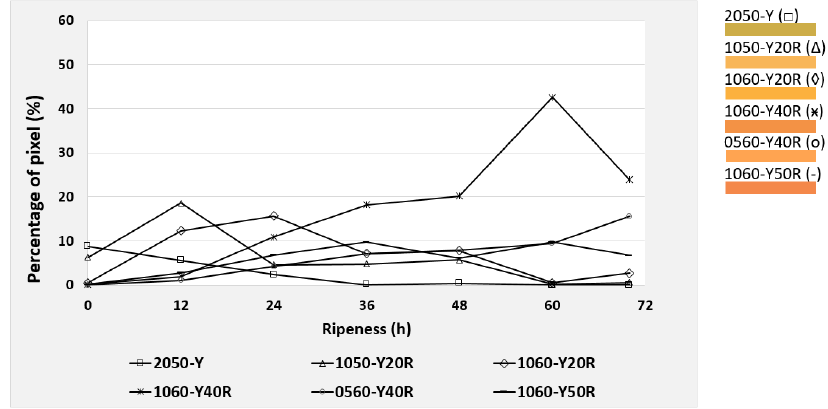
Figure 12. Development of the six most dominating pulp colors of cv. “ Mahachanok ” mangos during the 70 h post-ripening process, depicted as NCS color codes.